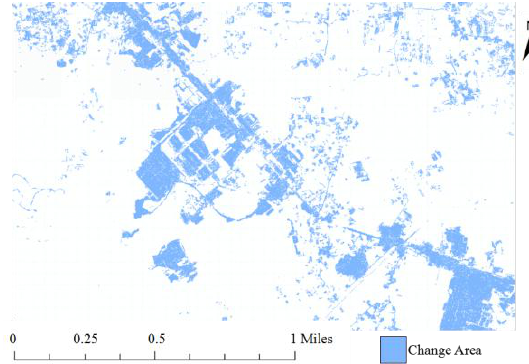
Figure 5. Result of change detection for the test